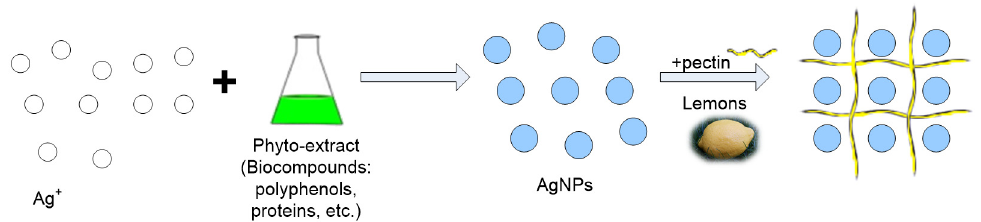
Figure 12. The mechanism of formation of pectin coat on developed AgNPs.